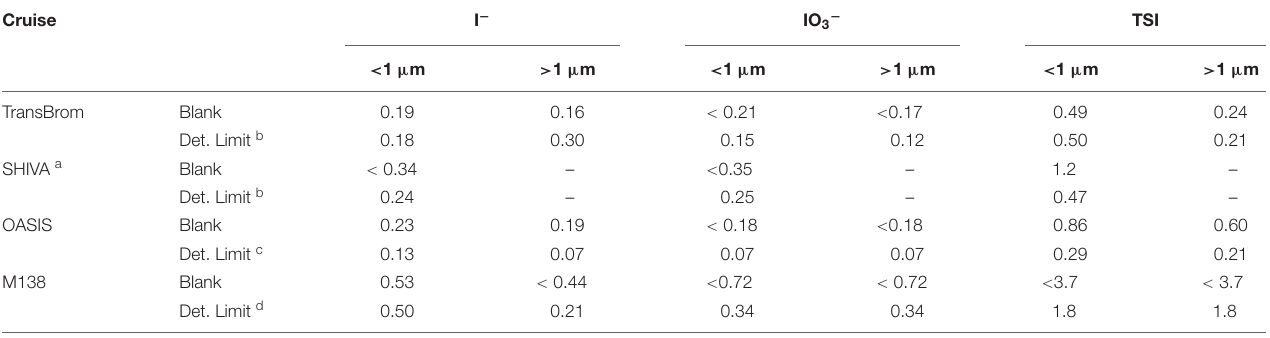
TABLE 2 | Blank values (nmol/filter) and detection limits (pmol m − 3 ) for iodine species measured during each cruise.